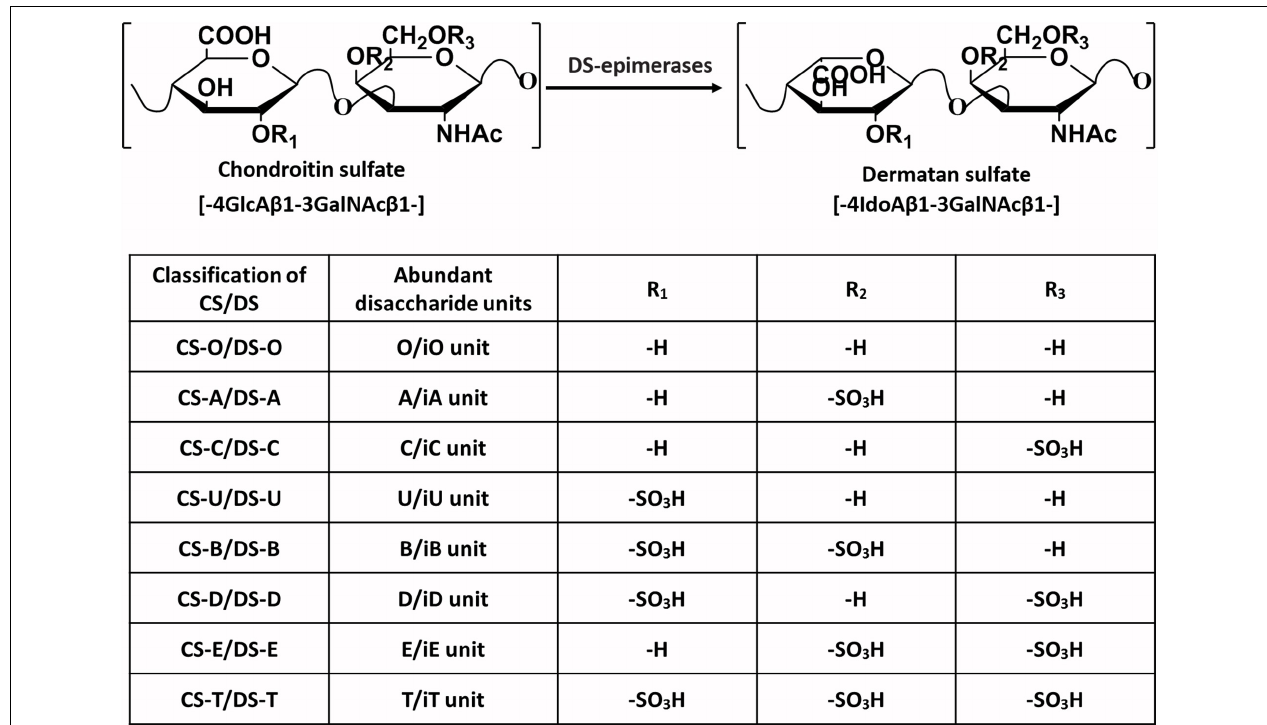
FIGURE 1 | The typical disaccharide units present in the backbone of the CS/DS chain. The major types of disaccharide units and sulfate group substitution positions that frequently exist in the CS/DS chains of different classifications are given.